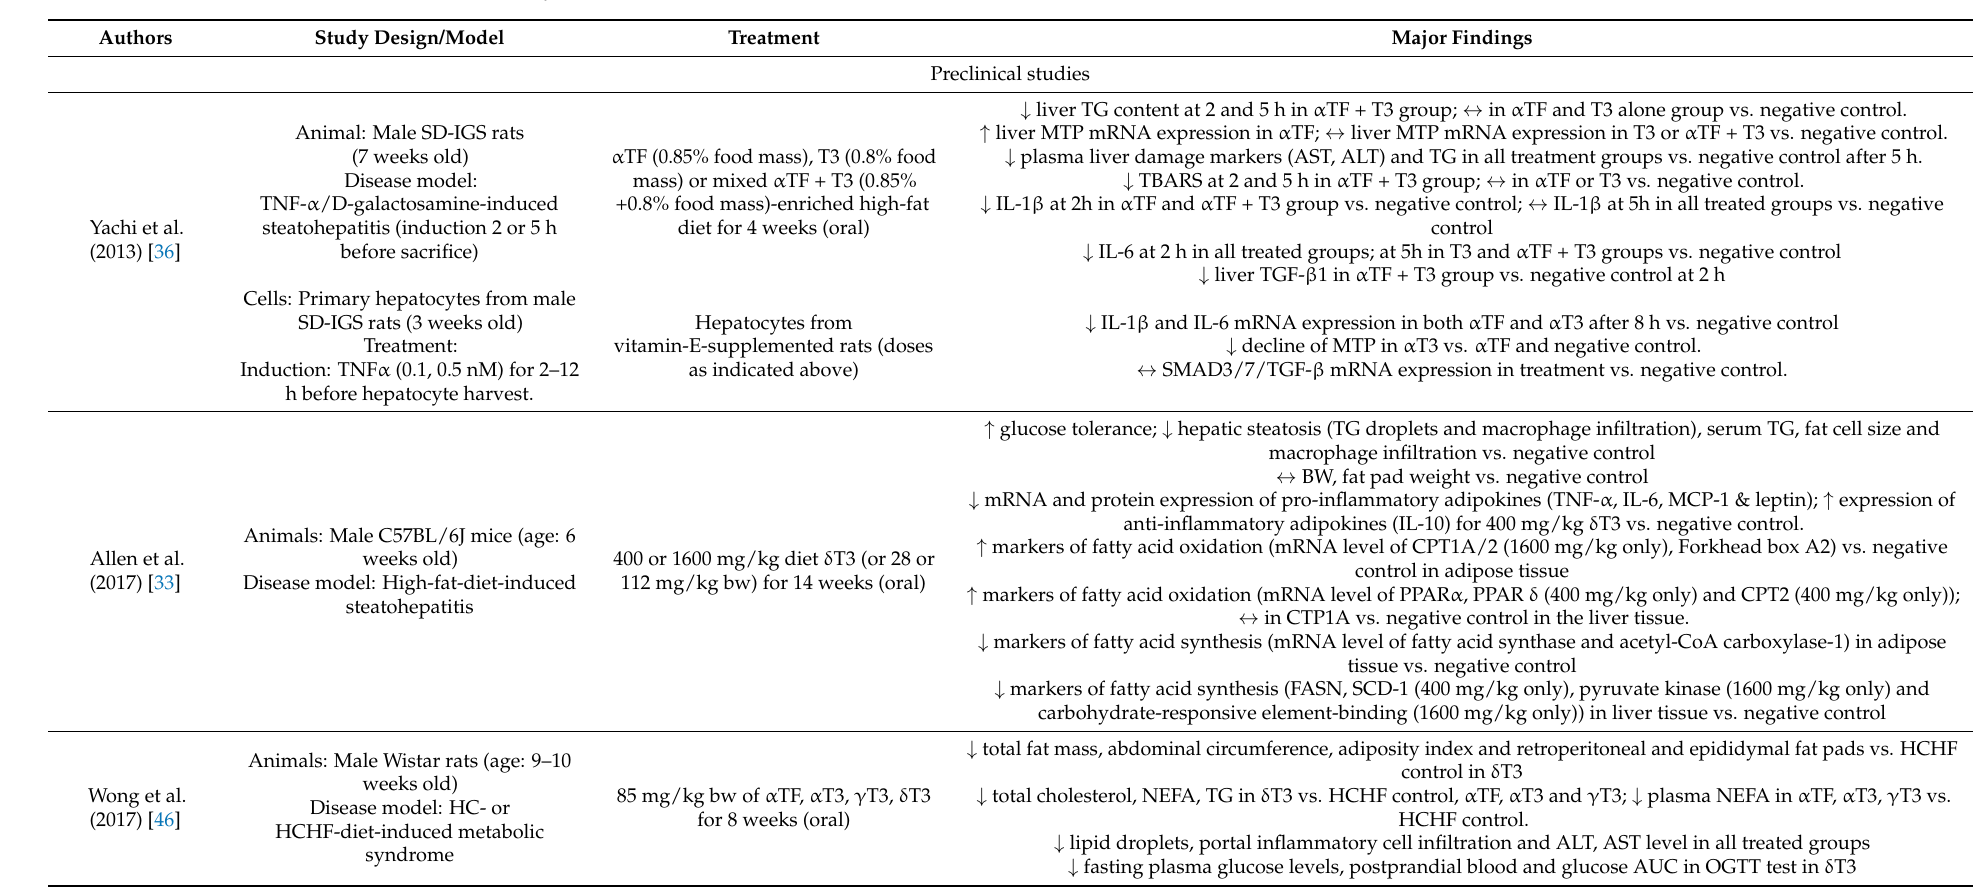
Table 1. Summary of the effects of T3 on